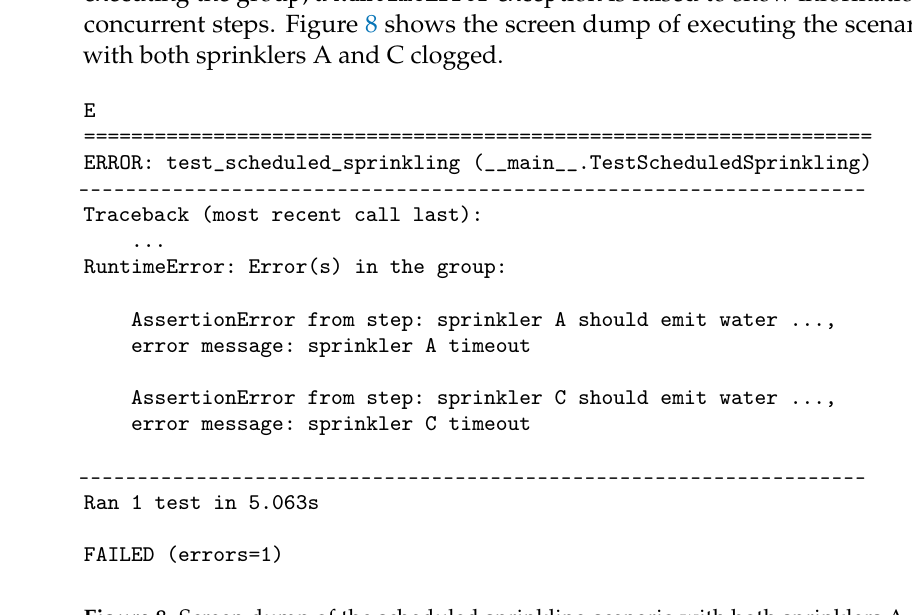
Figure 8. Screen dump of the scheduled sprinkling scenario with both sprinklers A and C